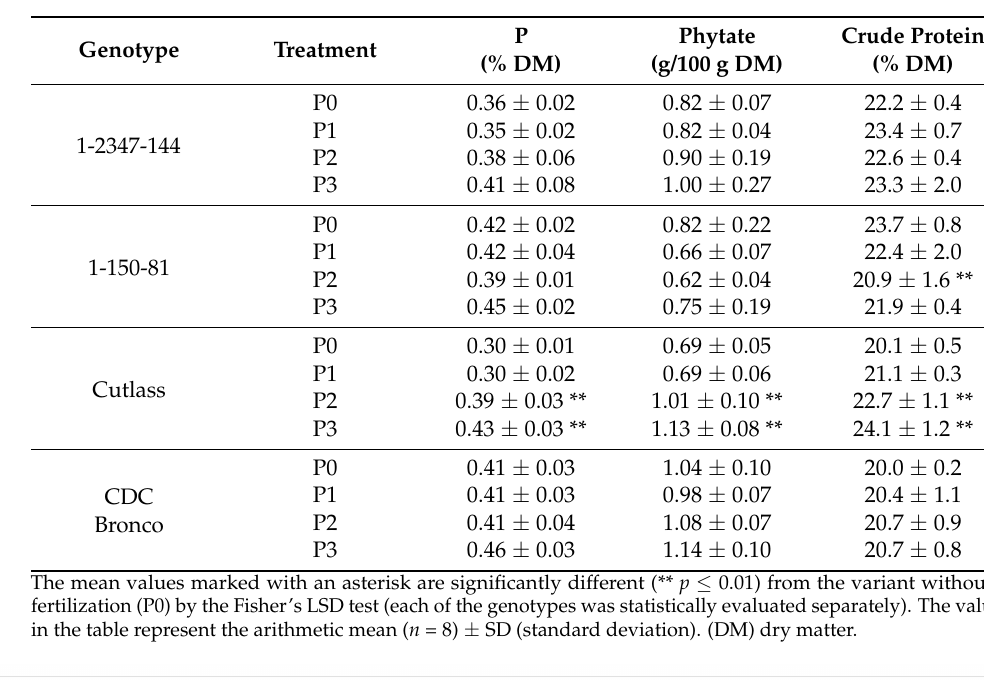
Table 3. The effect of the foliar phosphorus application on the content of phosphorous, phytate, and crude protein in pea seeds.